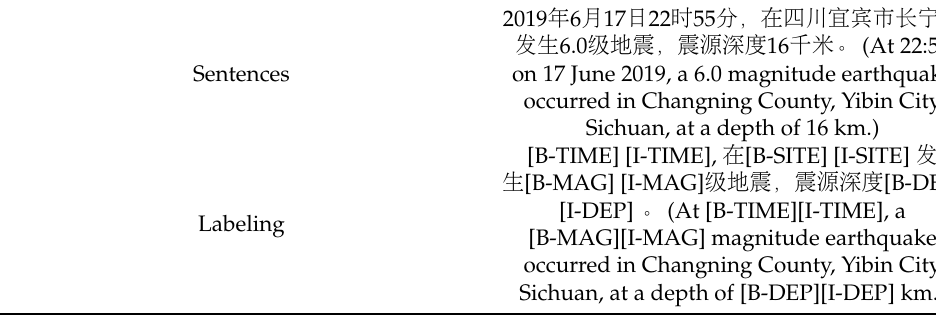
Table 2. BIO Chinese labeling method.